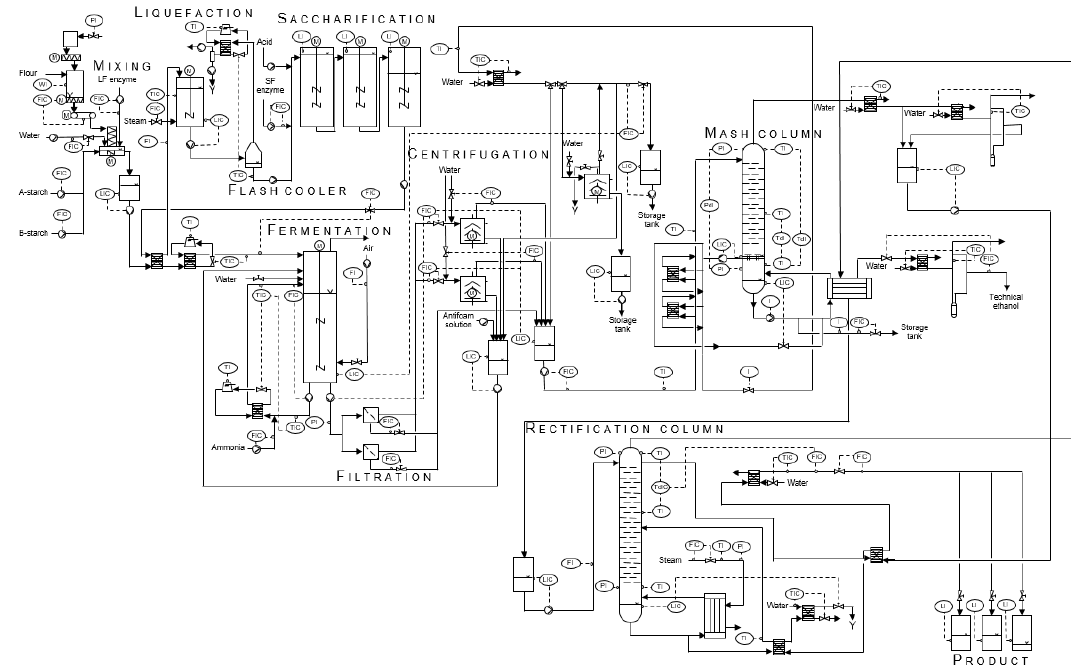
Figure 1. Flow diagram of Reppe‘s bioethanol plant showing the sections for the pre-treatment by mixing, liquefaction and saccharification as well as fermentation, filtration, centrifugation, mash distillation and rectification.